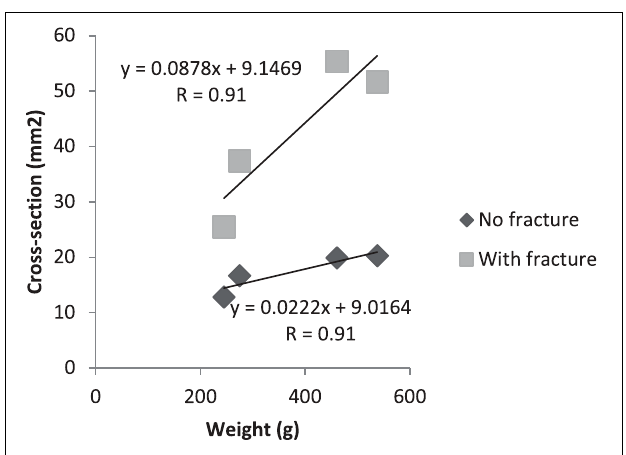
FIGURE 2 | Person’s correlation test between weight and cross-section, with and without fracture.